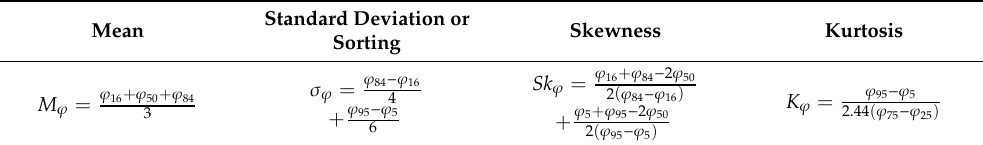
Figure 2. Cumulative distribution of the passing percentage of samples 13 and 17 for the three sieving methods. Table 2. Formulae used for calculation of the main granulometric parameters, according to Folk and Ward graphical measures